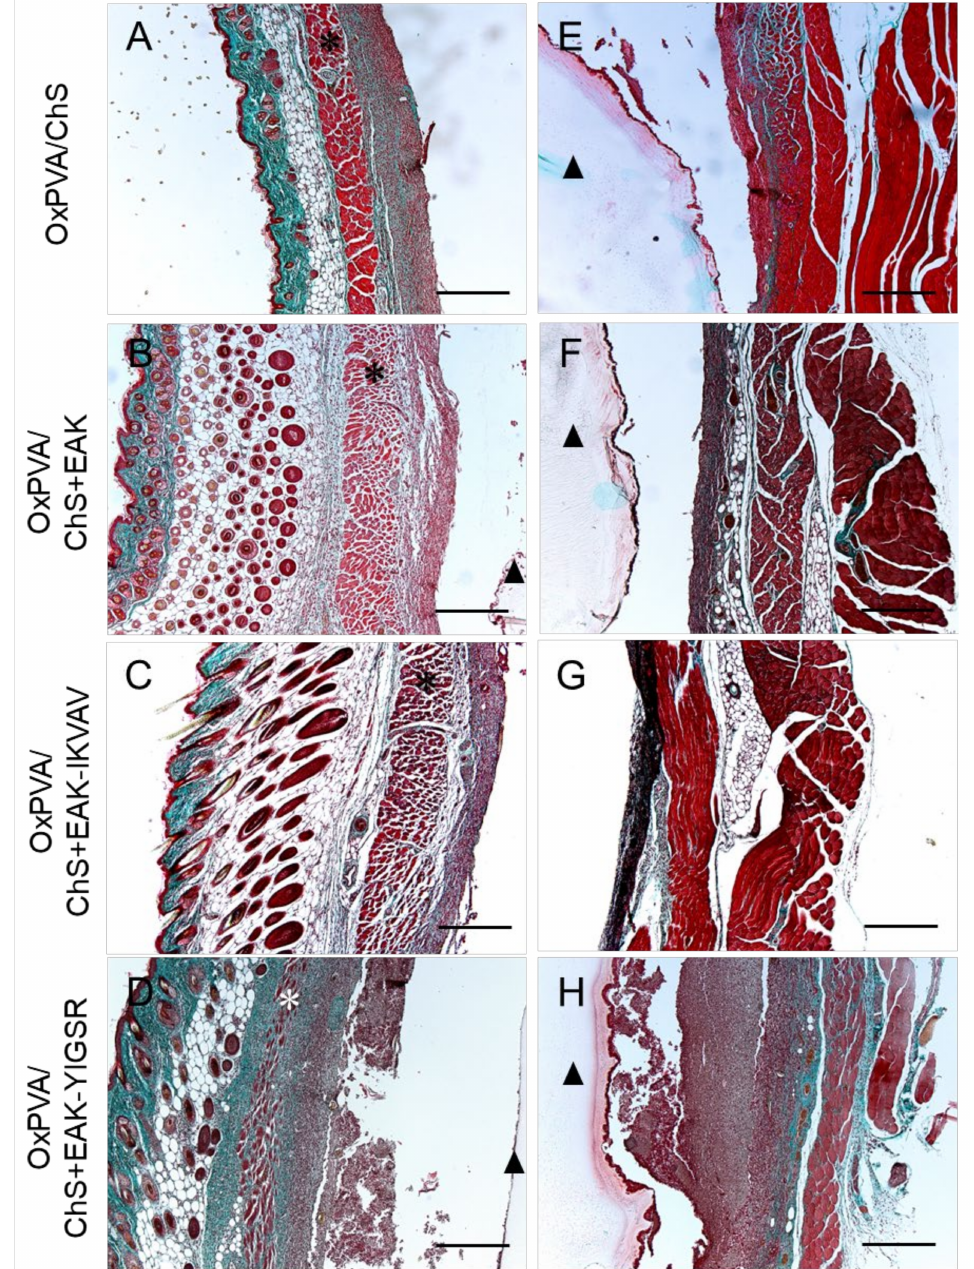
Figure 6. Masson’s Trichrome staining of subcutaneously implanted OxPVA/ChS-based scaffolds for the evaluation of the fibroconnective tissues (collagen, green) enveloping the superficial ( A – D ) and deep ( E – H ) aspects of the grafts. Scale bar: 400 µ m. (*: the panniculus carnosus within the host (cid:78) subcutaneous tissue; : the OxPVA-based